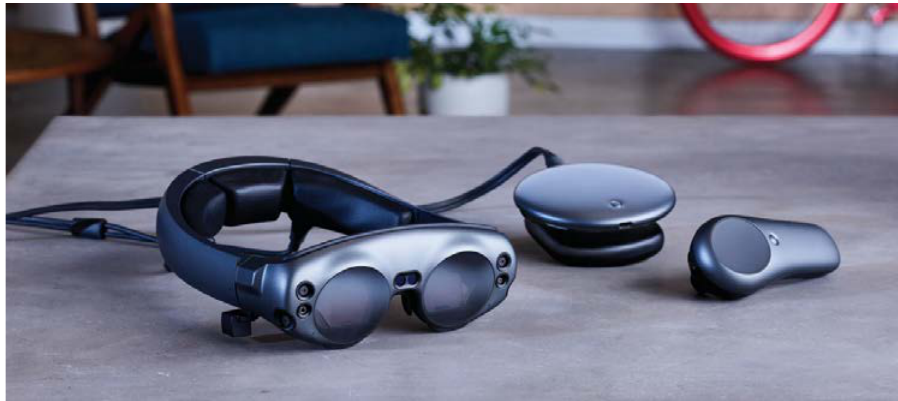
Figure 5. Magic Leap 1 hardware. From left to right: lightwear, lightpack, and control.